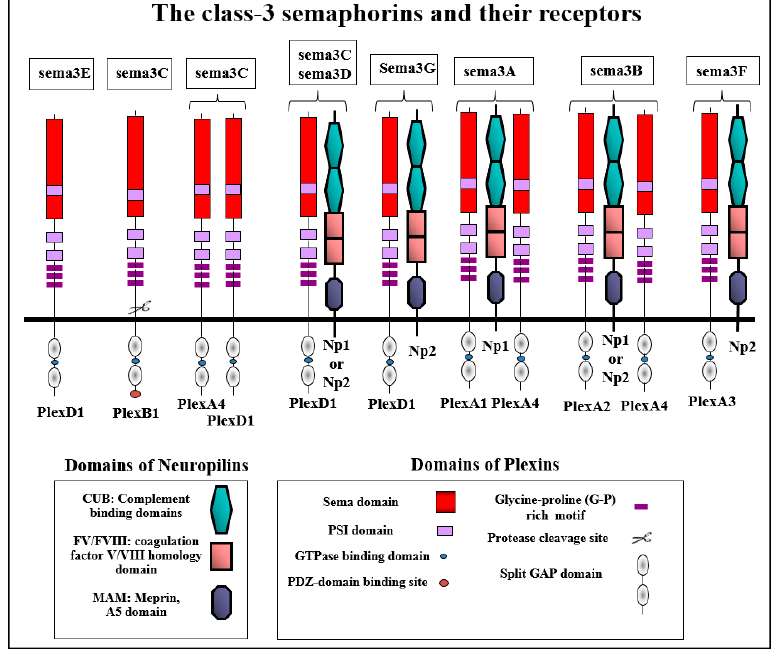
Figure 2 . The class-3 semaphorins and their receptors: The compositions of the functional receptor complexes that transduce the signals of the different class-3 semaphorins to induce cytoskeletal collapse in different cell types are shown. Plex stands as an abbreviation for plexin and Np as an abbreviation for neuropilins. Shown also are the main structural elements of the different plexins and neuropilins that function as class-3 semaphorin receptors. Neuropilins and plexins are single-pass transmembrane receptors. Neuropilins contain two complement-like binding domains (CUB domains also known as the a1 and a2 domains) that bind class 3 semaphorins. They contain two FV/FVIII coagulation factor homology domains (also termed the b1 and b2 domains). The b1 domain also participates in the binding of class-3 semaphorins. In contrast, VEGF binds to both. The MAM domain is believed to mediate neuropilin dimerization. The intracellular domain of the neuropilins contains a C-terminal SEA sequence that interacts with the PDZ domain containing proteins such as synectin. Plexins also contain a sema domain in their extracellular domain. They contain PSI (Plexin, Semaphorin, Integrin) motifs and IPT/(G-P)-rich motifs involved in the binding of semaphorins. The intracellular part contains a split GTPase activating (GAP) domain separated by a GTPase-binding domain that binds small GTPases such as